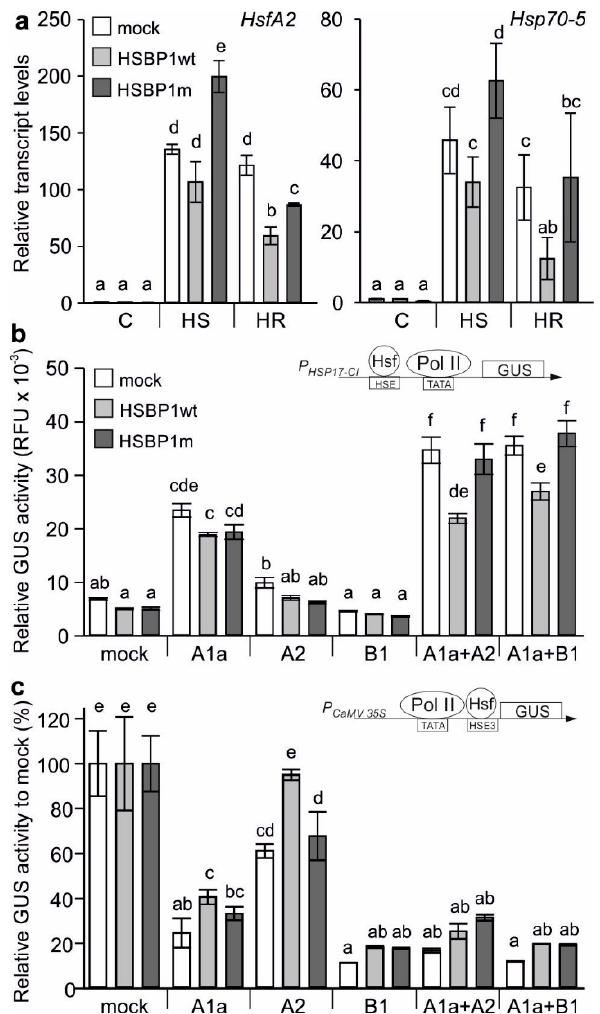
Figure 3. Effect of SlHSBP1 and SlHSBP1m on properties of major Hsfs. ( a ) Transcript levels of HsfA2 and Hsp70-5 in protoplasts expressing SlHSBP1 or SlHSBP1m in comparison to mock samples. Protoplasts were either kept at 25 °C (control) or exposed to 40 °C for 1 hour (HS) and then allowed to recover for 1.5 hours at 25 °C (HR). Values are expressed relative to the mock control sample and are the average of three replicates and error bars are ±SE. EF1a was used for normalization. ( b ) The transactivation activity of single or combinations of HsfA1a, HsfA2, or HsfB1 in the presence of HSBP1 or HSBP1m. P HSP17-CI ::GUS was used as reporter. ( c ) GUS repressor for elucidation of Hsf DNA binding capacity using the P CaMV 35S-HSE3 ::GUS reporter. The repression of activity is calculated relative to a sample where no Hsf was expressed for each HSBP1 , HSBP1m , and mock control. Values are the average of three individual replicates ±SD. RFU: relative fluorescence unit. Different letters